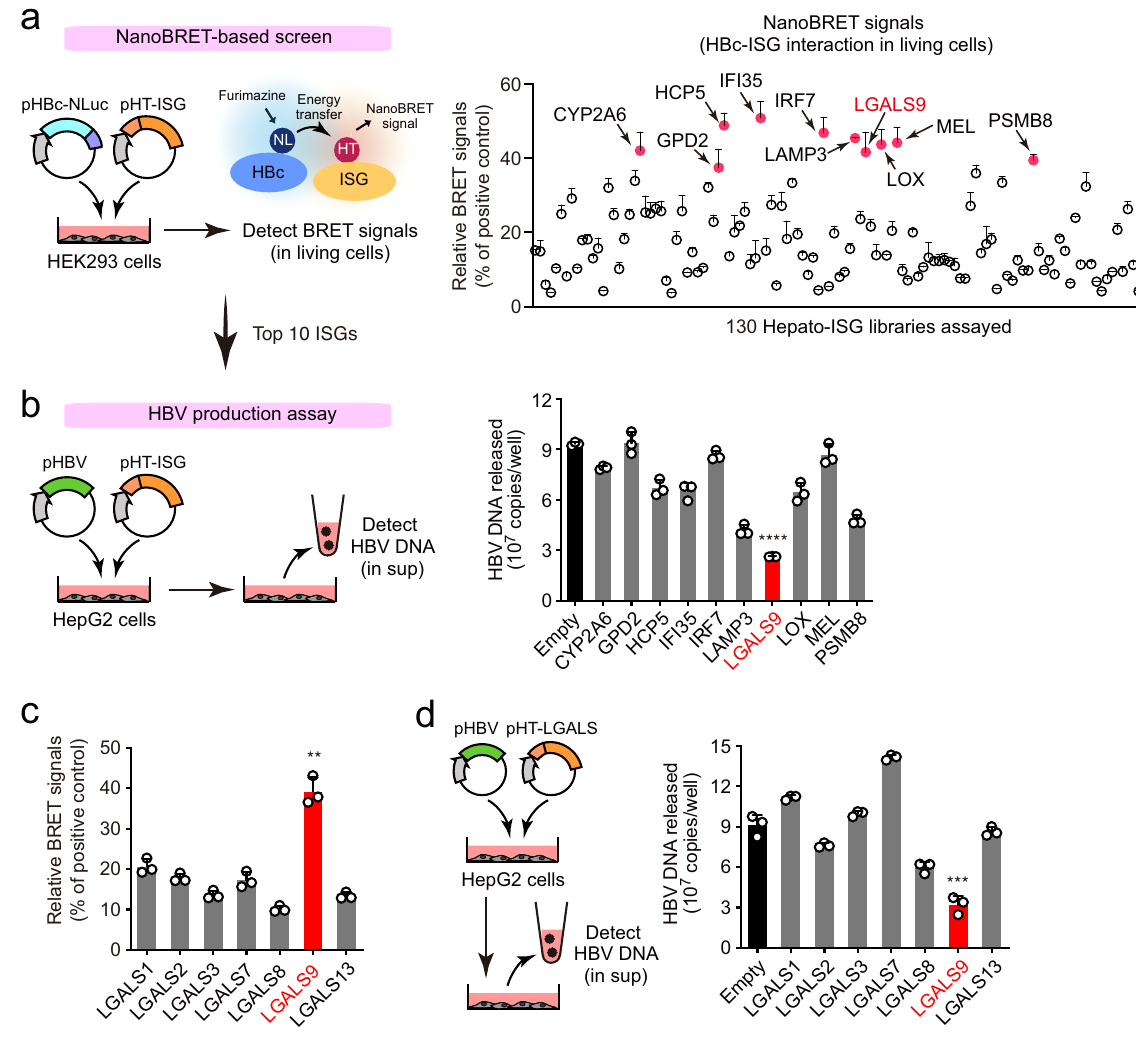
Fig. 1 Identi fi cation of HBc-binding ISG proteins that regulates HBV production. a NanoBRET-based screen to identify HBc-interacting proteins encoded by ISGs in living cells. HEK293 cells were co-transfected with NanoLuc (NL)-conjugated HBc (derived from HBV genotype C) and HaloTag (HT)-fused ISG expression vectors (130 genes). Following, HT-618 ligand and furimazine substrate were added. If two proteins were within 200 nm of each other, NanoBRET signals were detected. The interaction between NL-HBc and HT-HBc was used as the positive control. The top 10 proteins with the highest NanoBRET signals are indicated by arrowheads. The mean ± SEM of three independent determinations is plotted. b LGALS9 suppresses HBV particle production. HepG2 cells were transfected with the HBV molecular clone pHBV and either of the indicated ISG expression vectors. Cells were washed 4 h after transfection. Three days after transfection, viral DNA in culture supernatants was measured by qPCR. c LGALS9, but not other galectin family proteins, interacts with HBc. NanoBRET analysis as described in a was performed on HepG2 cells expressing NL-HBc and the indicated HT-LGALS proteins. d LGALS9 speci fi cally suppresses HBV production. HBV production assay as described in b was performed on HepG2 cells expressing pHBV and the indicated HT-LGALS proteins. Bar charts are presented as a mean ± SD ( n = 3 experiments). **** P < 0.0001 ( b ), *** P = 0.0006 ( d ), two-tailed unpaired t -test. Source data are provided as a Source Data fi